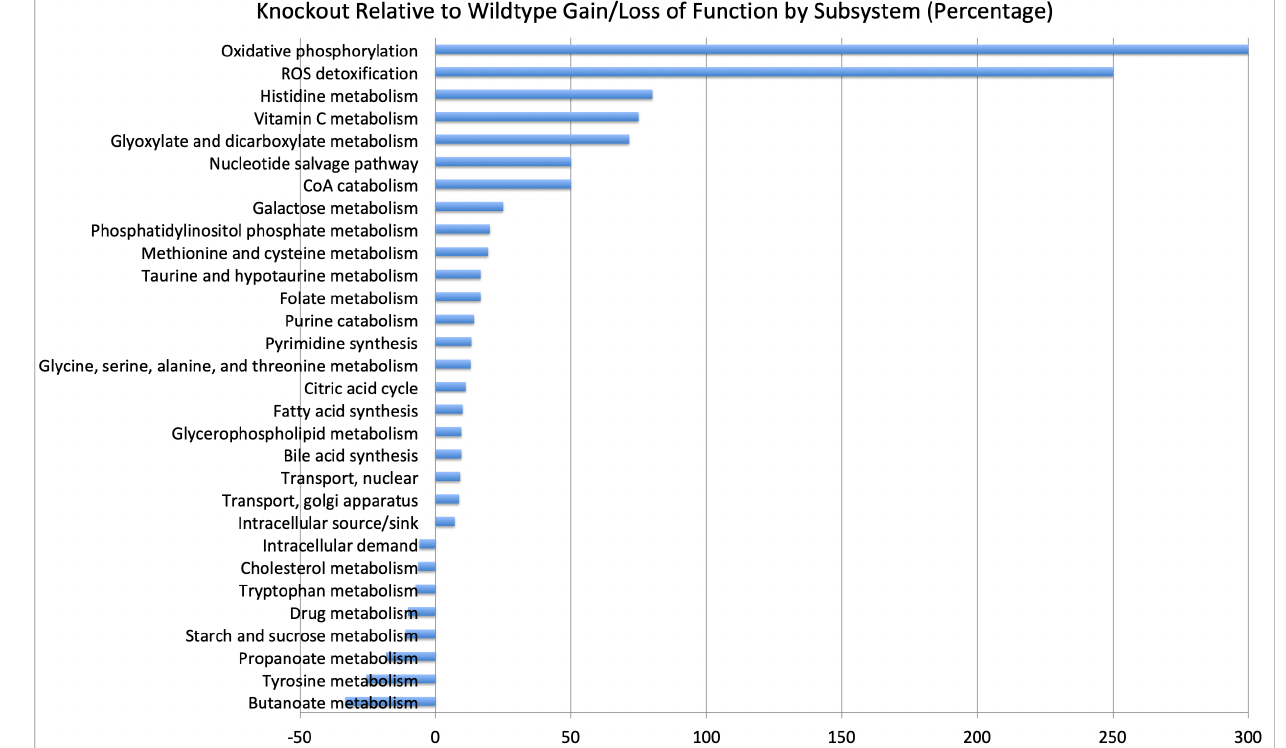
Figure 7. Comparison between Urat1/Rst KO and WT GEMs based on reaction differences according to subsystem classification. Reactive oxygen species handling and oxidative phosphorylation-related reactions exhibited the biggest changes. Further evaluation of the reactions implicating other metabolic sub-systems revealed that the changes were generally involved in redox reactions and cofactor